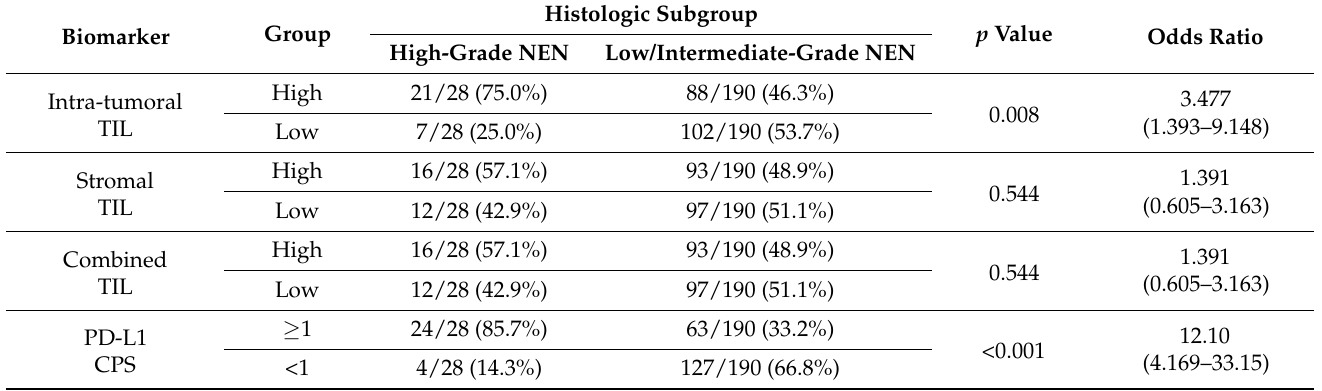
Table 1. Analysis of PD-L1, CPS, and TIL densities between histologic groups.